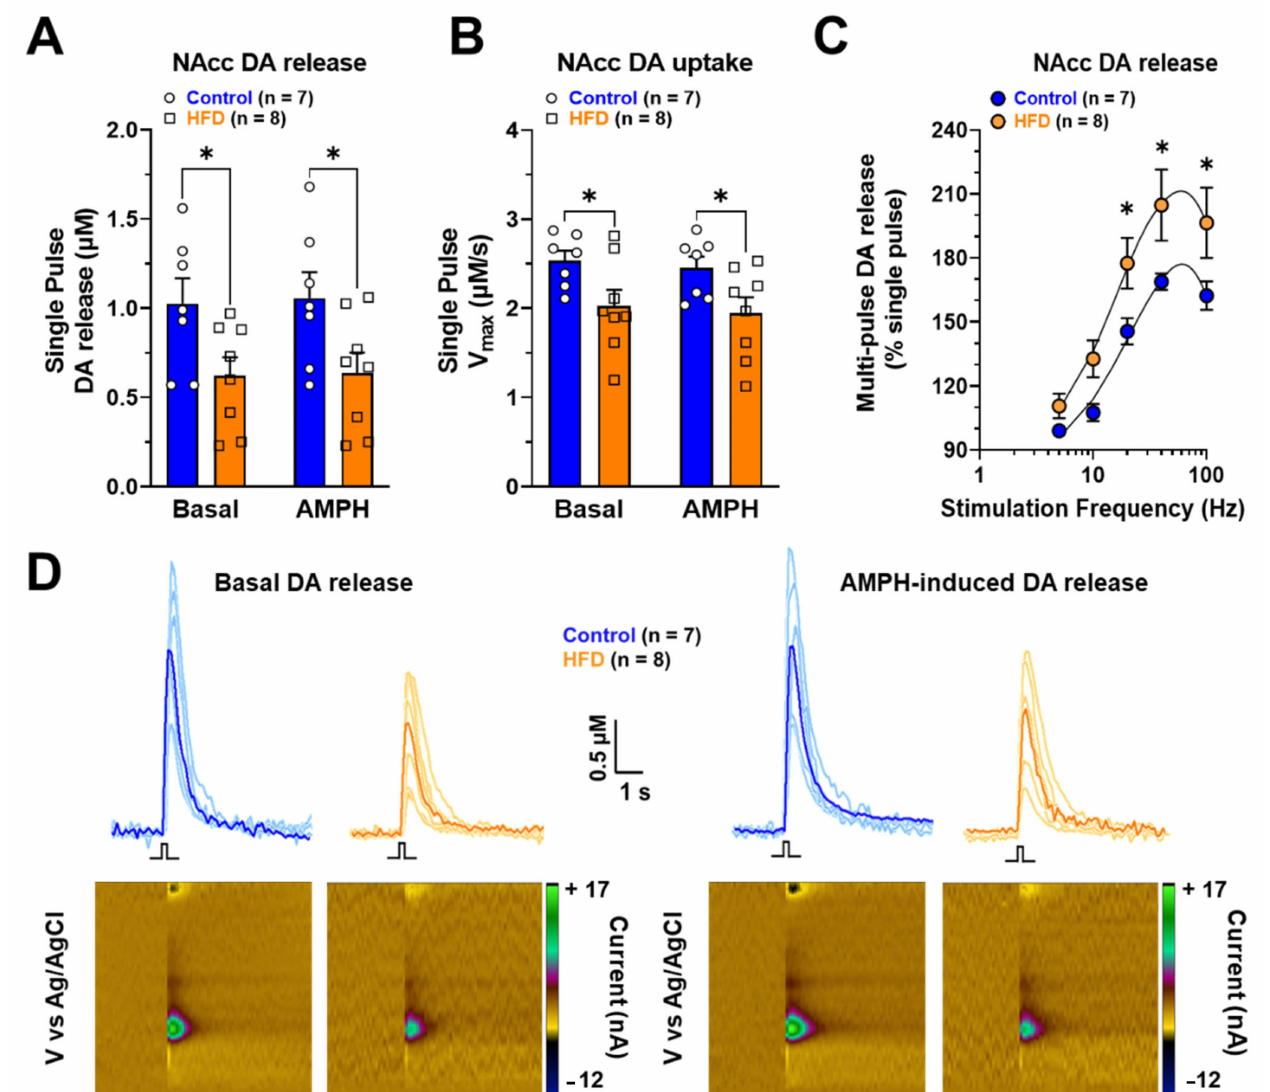
Figure 5. NAcc DA release in slices of normal weight and obese male rats. ( A ) NAcc DA release stimulated by a single pulse in basal condition and with 0.1 µ M amphetamine (AMPH). ( B ) Maximal rate of DA uptake (Vmax) in NAcc. ( C ) Phasic DA release in NAcc stimulated by five pulses at 5, 10, 20, 40, and 100 Hz frequencies. ( D ) Representative line traces showing peak height (DA release) and representative color plots in a slice of rats fed with chow or HFD for six weeks. Blue and orange represent the mean DA release in control and HFD male rats, respectively. The statistical analysis used was a two-way ANOVA multiple comparisons test (Figure 5A) (* p < 0.05). Monophasic stimulation was 400 µ A during 4